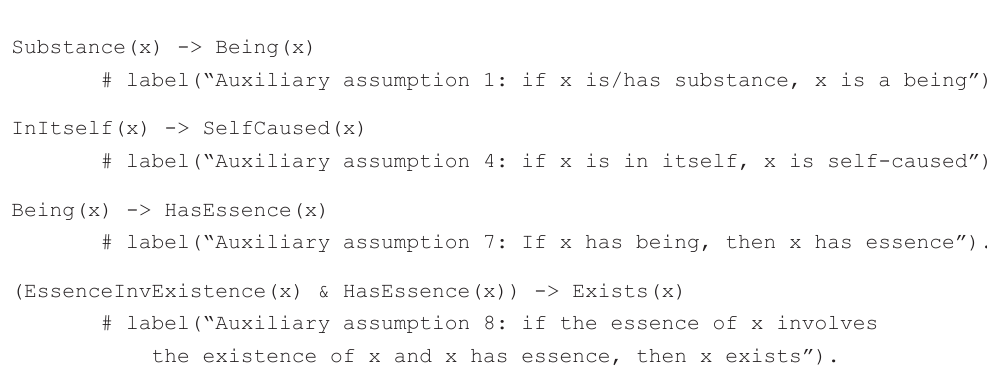
Figure 5: A mace4 script for generating a model that shows the independence of the (SE) from the DAPI. Appendix 2 depicts a model, produced by the script shown in Figure 5, that shows the independence of (SE) from the DAPI. Thus, (SE) does not follow from the DAPI. Given this result, by the Deduction Theorem, Prop. 7 does not follow from the DAPI, either. Thus Prop. 7, contrary to what Spinoza suggests, does not help us to derive (GE).